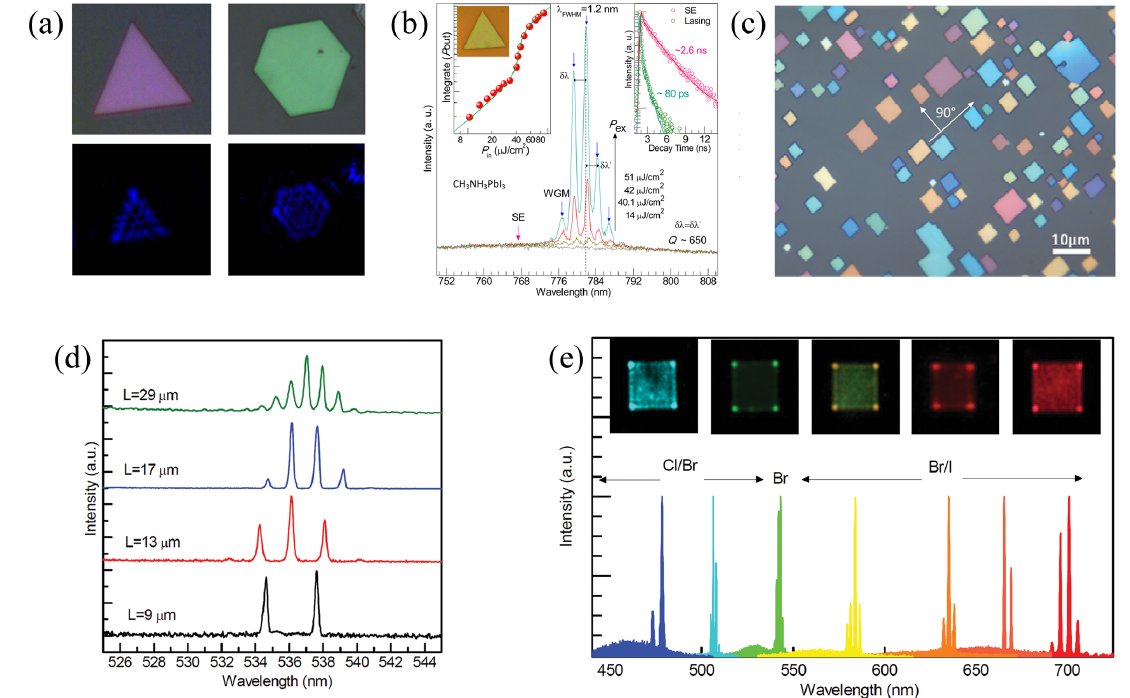
Figure 7. ( a ) Far-field optical image of two typical MAPbI 3 nanoplatelets under the illumination of white light (upper panel) and pump laser (bottom panel) providing evidence of clear diffraction patterns inside the WGM cavity. ( b ) Excitation density dependence of the PL spectra of a typical MAPbI 3 triangular nanoplatelet (optical image inset; thickness, 150 nm; edge length, 32 µ m). Left inset: integrated output emission (P out ) over the whole spectra range as a function of pumping fluence (P in ) using log-log scale, providing evidence of the lasing threshold. Right inset: PL relaxation dynamics below (pink, SE) and above (dark green, lasing) the threshold. ( a , b ) adapted with permission from [48]. American Chemical Society, 2014. ( c ) Optical image of CsPbBr 3 nanoplatelets showing square or rectangular shapes and rich colors. ( d ) Multimode lasing spectra of four nanoplatelets with different edge length from 9 to 29 µ m. ( e ) Multicolor WGM microlasers based on inorganic perovskites with different composition. ( c – e ) adapted with permission from [49]. John Wiley and Sons,